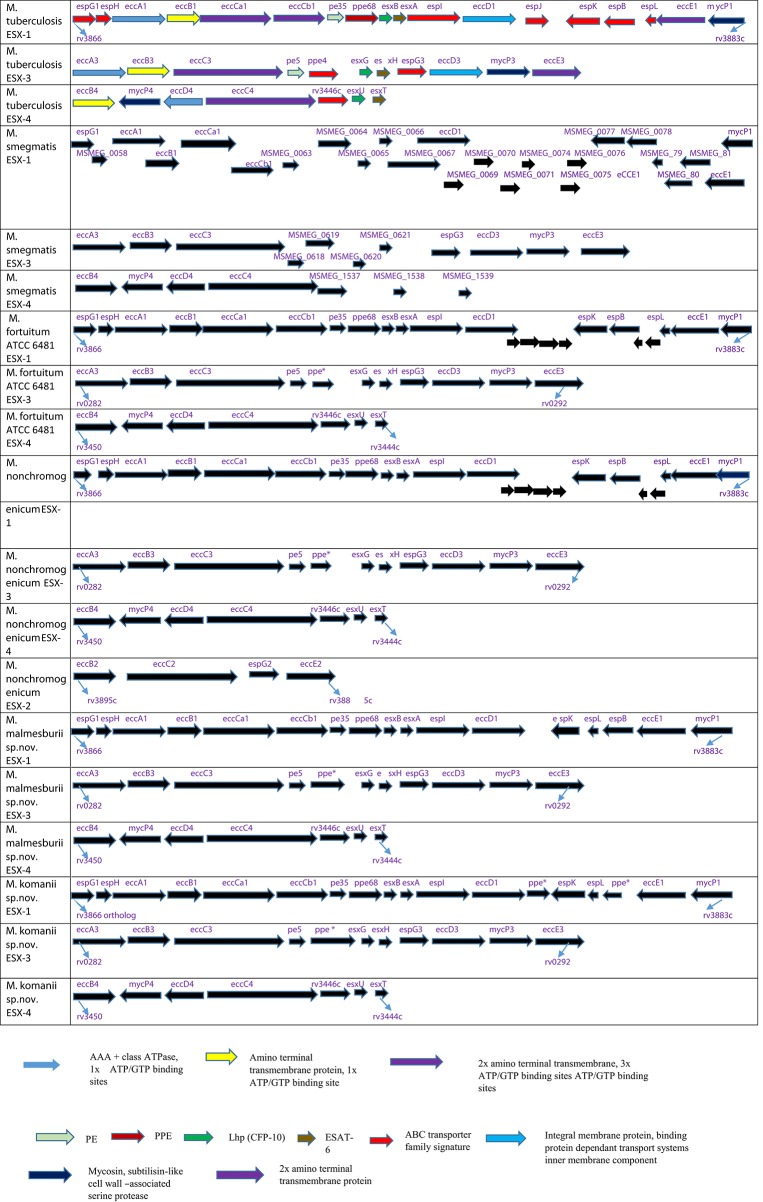
Schematic representation of the genomic arrangement of orthologs of genes present in three ESAT-6 gene cluster regions: ESX-1, ESX-3, and ESX-4 of M. fortuitum, M. malmesburii sp. nov., M. nonchromogenicum (as well as ESX-2), and M. komanii sp. nov., compared to M. tuberculosis and M. smegmatis. M. tuberculosis annotation was also used for the NTM orthologs (except for M. smegmatis). Protein coding sequences are represented by blocked arrows reflecting the relative lengths of the genes and the direction of transcription. Genes of M. tuberculosis are color coded according to the protein families they encode for (Gey van Pittius et al., 2006). The unannotated genes in NTM encode for hypothetical proteins.